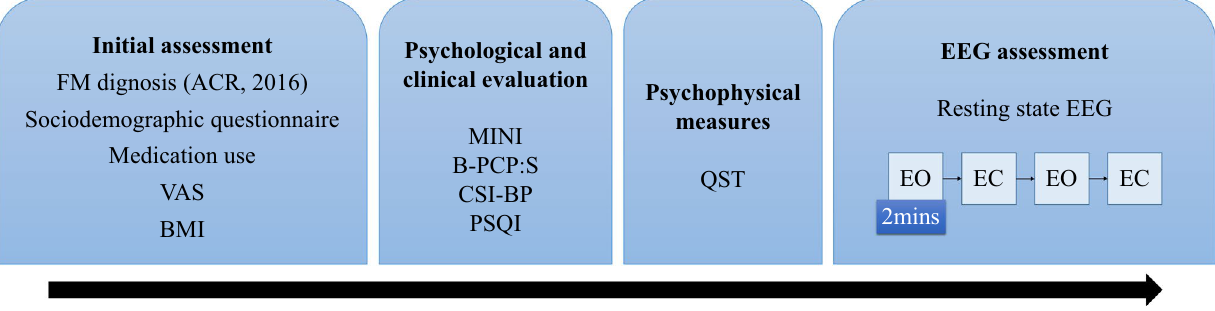
Figure 1. Flowchart of the study assessments. FM = Fibromyalgia; ACR = American College of Rheumatology; VAS = visual-analogue scale (10 cm) for pain levels; BMI = body mass index; MINI = Mini International Neuropsychiatric Interview; B-PCP:S = Brazilian Profile of Chronic Pain: Screen; CSI-BP = Central sensitization inventory—Brazilian Portuguese version; PSQI = Pittsburgh Sleep Quality Index; QST = Quantitative Sensory Testing; EO = eyes open; EC = eyes closed. Measures were not sequentially applied over